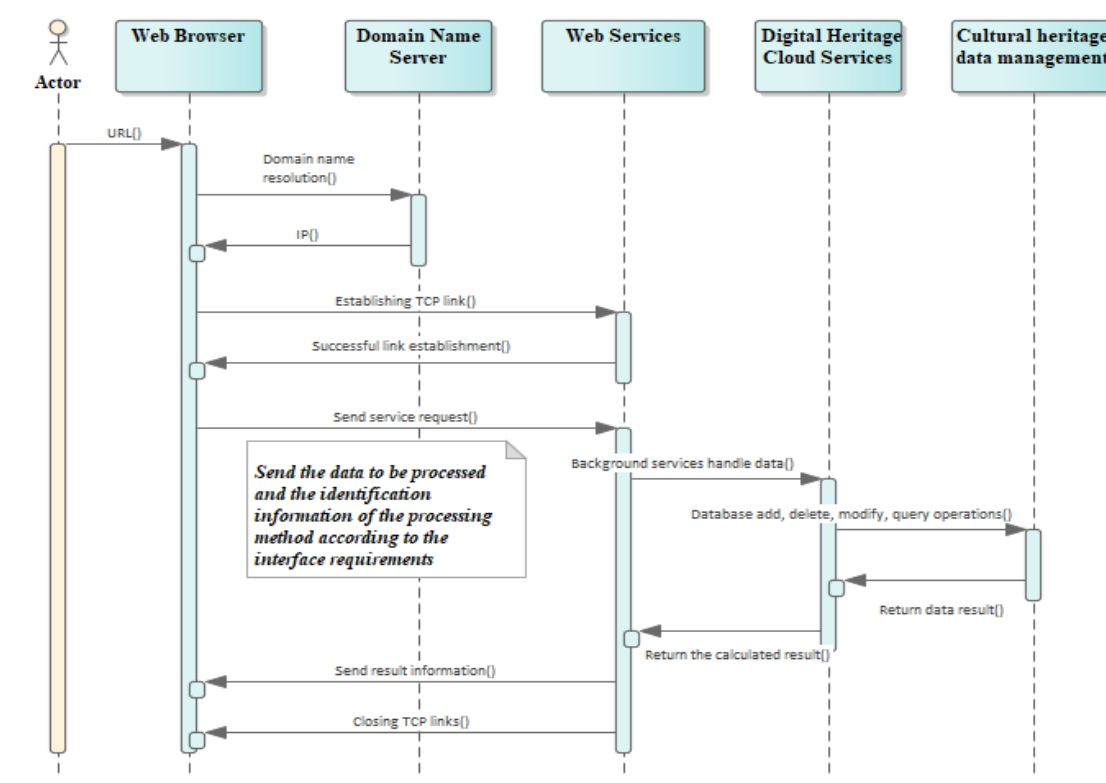
Figure 4. HTTP request processing sequence